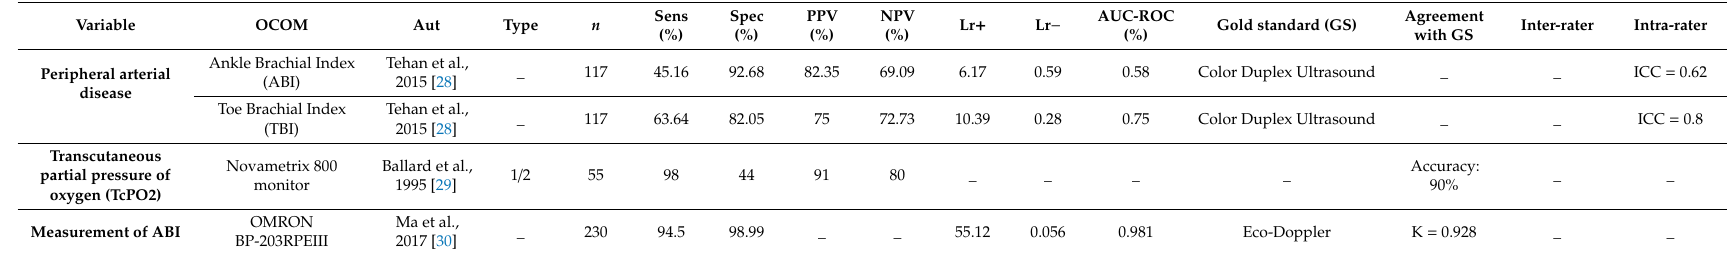
Table 2. Variables related to PAD and the OCOMs validated for their assessment.